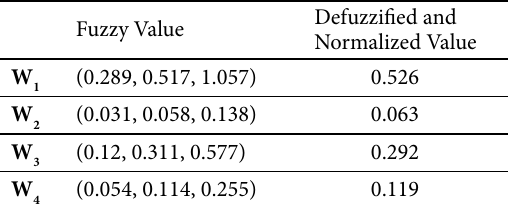
Table 6. Weights of criteria Fuzzy Value